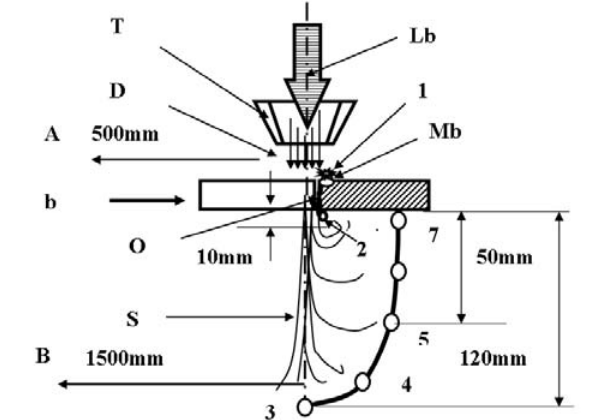
Fig 1. Nanoparticle generation and selection in the concentrated power and gas flow. 1 – 7 are sites particle collection from chamber-catcher, or 500 and 1500 mm from the laser beam action zone, A – B the direction of particle movement, D - gas flow, Lb - laser beam, Mb - melt bath, O - oxide film, S - erosion product flow, T - nozzle, b – the sample A solid-state pulsed Nd: YAG laser with an average power of 250W was used. The wavelength of the pulse generated was 1064 nm, the duration was 2 – 0.6ms, and the repetition frequency was 150 – 3 Hz